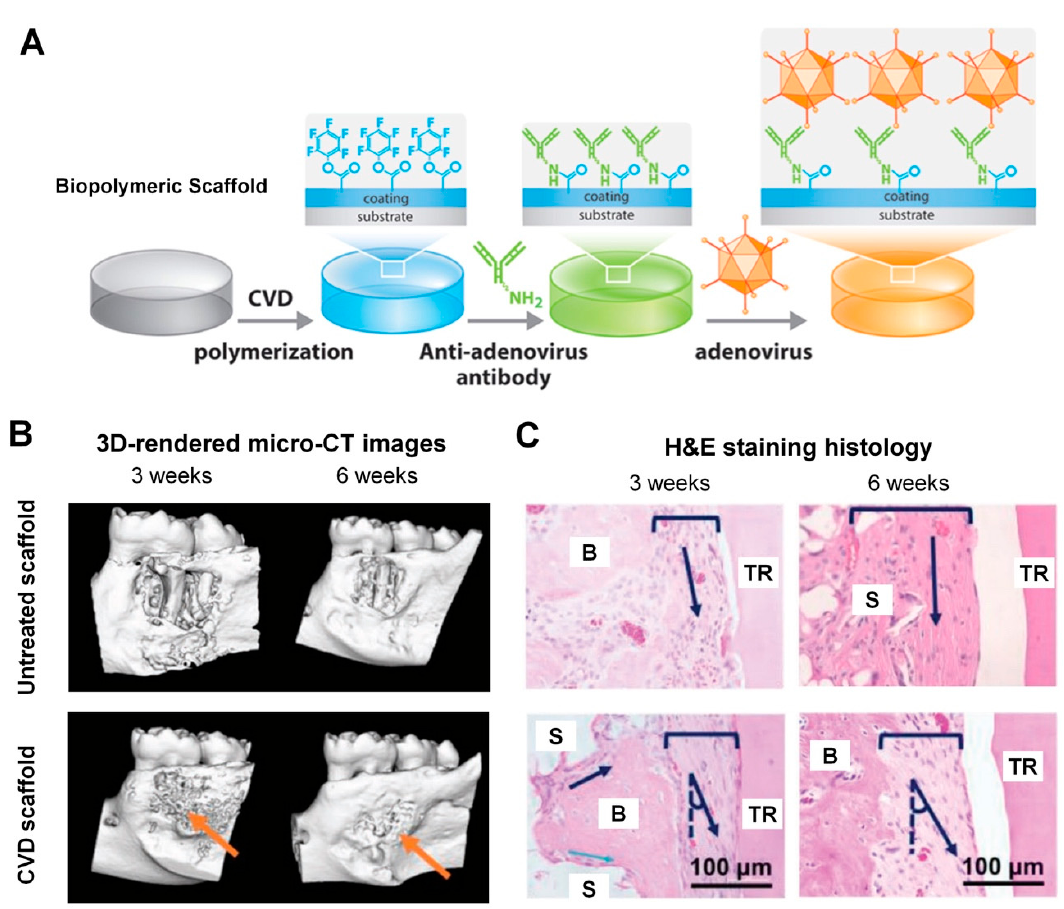
Figure 6. Immobilization of viral vectors for periodontal tissue regeneration. The schematic illustration showed the process of viral vector (adenovirus) attachments on biomaterial surfaces ( A ). Immobilized gene therapy technique promoted alveolar bone formation in the fenestration periodontal defect sites compared with untreated scaffolds. The 3D micro-computed tomography (micro-CT) images could be quantitatively and qualitatively analyzed for the mineralized tissues regeneration with cementum-denuded root coverage ( B ). The hematoxylin & eosin staining histology demonstrated alveolar bone formation around tooth-root surfaces with the secureness of PDL regions ( C ). (B: bone, TR: tooth root, S: scaffold, arrow: orientation of cell nuclei to tooth-root). Adapted